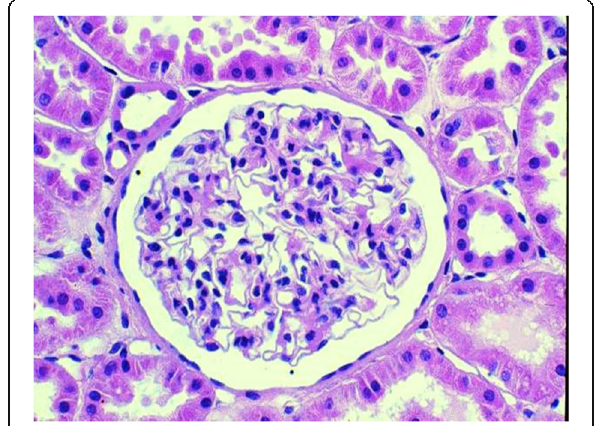
Fig. 12 Photomicrograph of control kidney showing normal architecture (H&E; ×